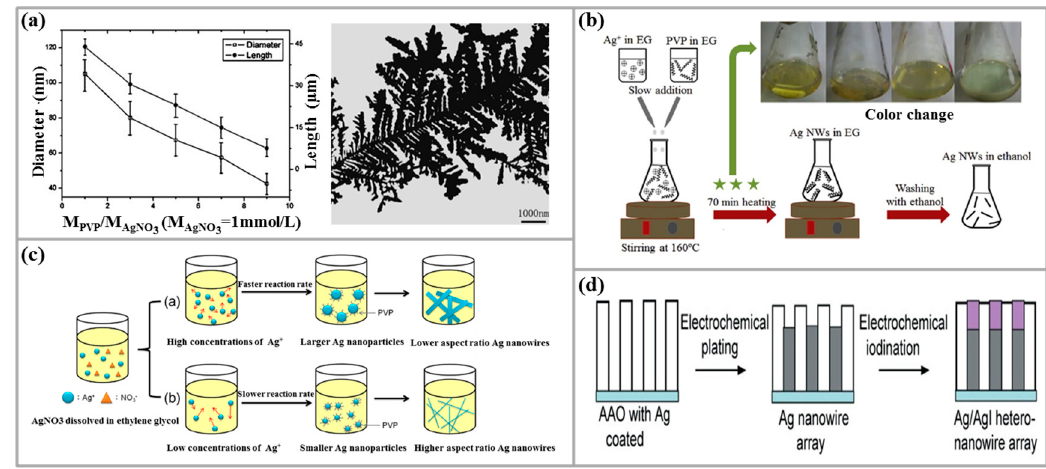
Figure 2. Synthesis of Ag NWs and some influencing factors: ( a ) Diameters and lengths of the Ag NWs as a function of the molar ratio of PVP / AgNO 3 and transmission electron microscope (TEM) image of Ag nanostructures obtained with 0.5 mL of Ag seeds added [45]. Copyright 2004, Crystal Growth. ( b ) Schematic representation of the polyol synthesis of Ag NWs [58]. Copyright 2016, Materials Chemistry and Physics. ( c ) Schematic of the di ff erent concentrations of AgNO 3 for synthesis of Ag NWs with di ff erent diameters [54]. Copyright 2014, Solid State Chemistry. ( d ) Schematic illustration of template synthesis procedures for obtaining the AgI / Ag heterojunction structures [84]. Copyright 2007, Advanced Functional